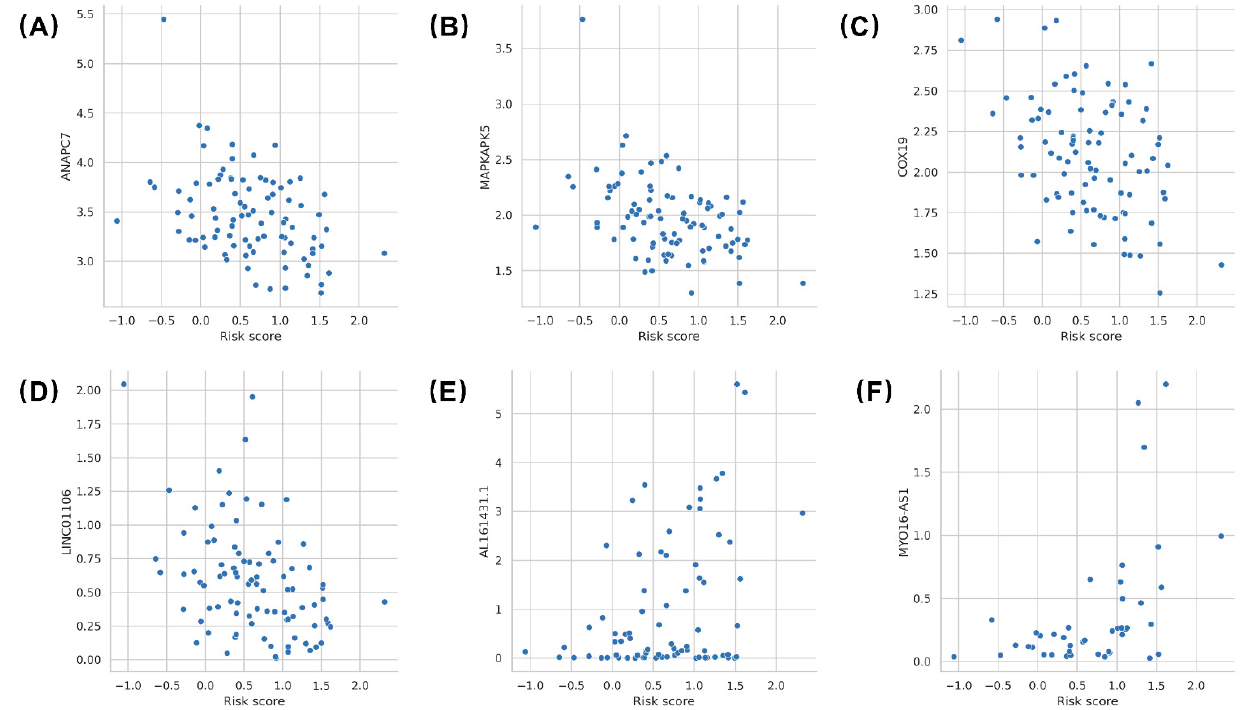
Figure 6. Correlates between risk scores and gene expression levels. Biological correlation between MibcMLP risk scores and ( A ) the ANAPC7 expression ( N = 90 samples), ( B ) the MAPKAPK5 ex- pression ( N = 90 samples), ( C ) the COX19 expression ( N = 90 samples), ( D ) the LINC01106 expression ( N = 90 samples), ( E ) the Al161431.1 expression ( N = 78 samples), and ( F ) the MYO16-AS1 expression ( N = 43 samples) available for the TCGA dataset.